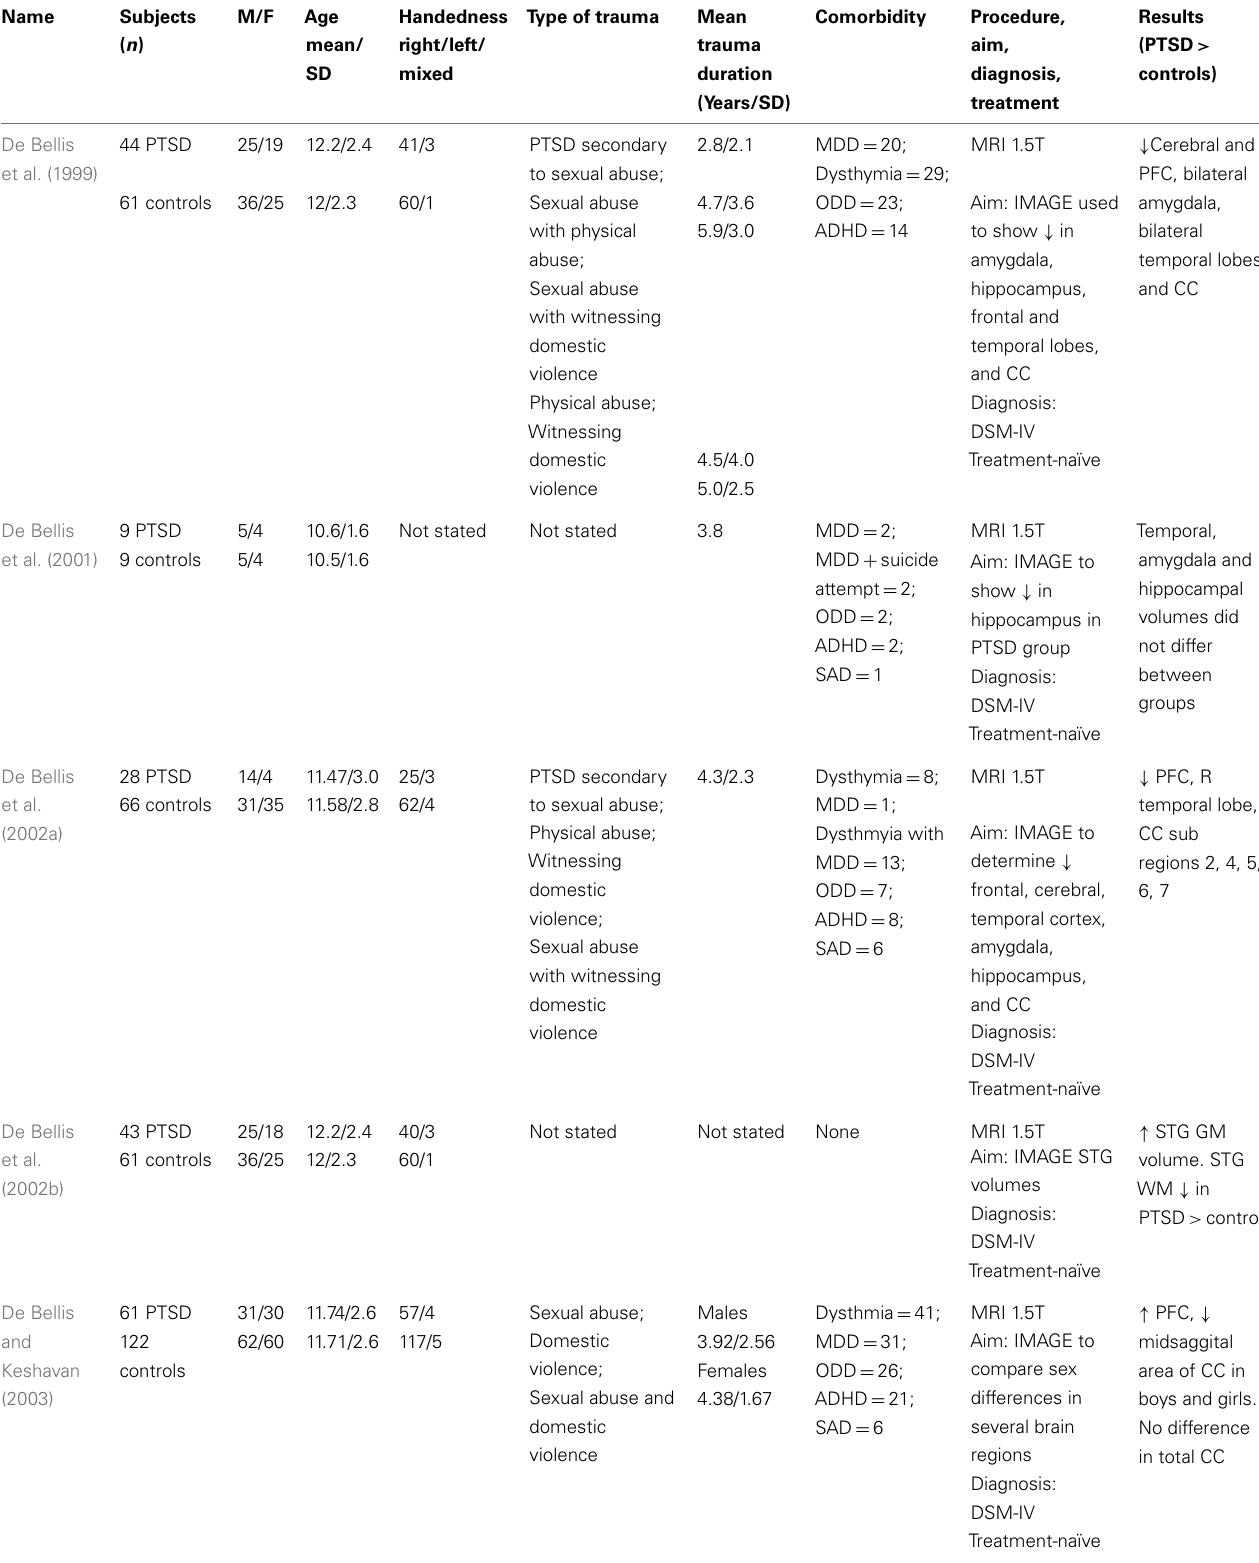
Table 1 | Structural magnetic resonance imaging (sMRI) studies in